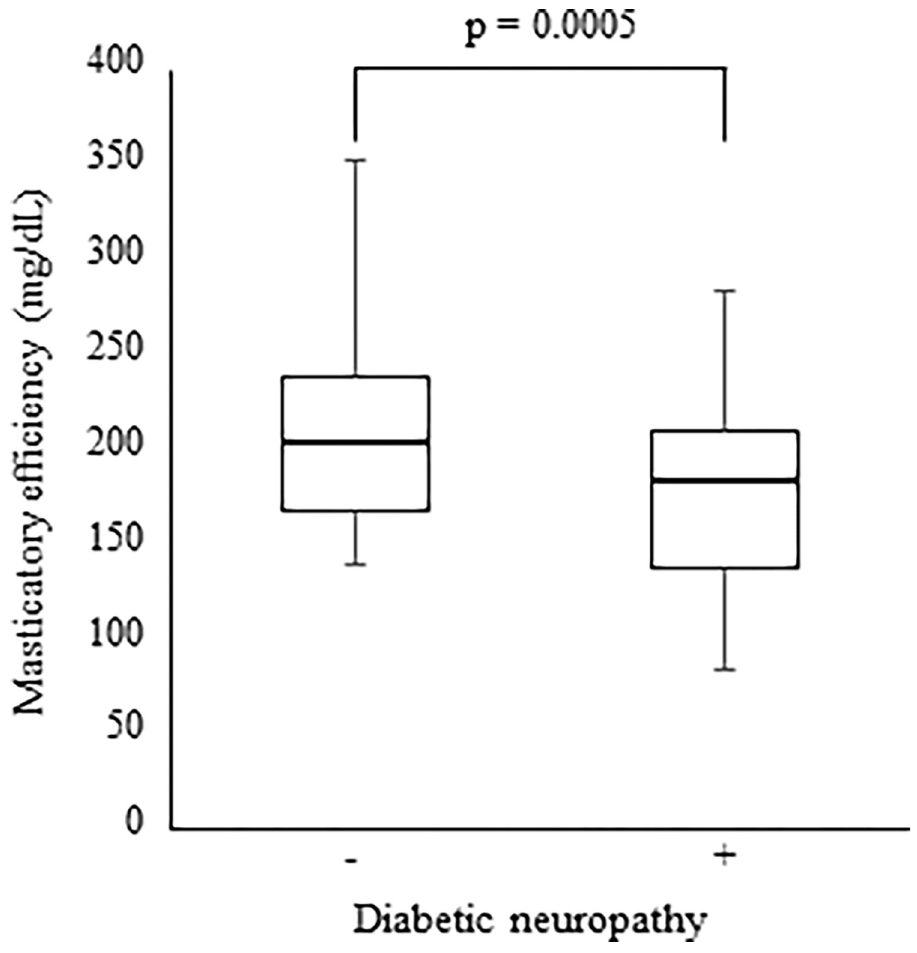
Fig 3. Effect of diabetic neuropathy on masticatory efficiency in patients with more than 20 remaining teeth. Statistical significance was defined as a two-sided p value of < 0.05.